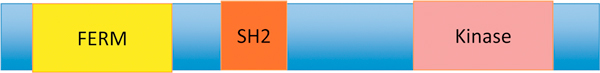
Organization of the TYK2 protein.